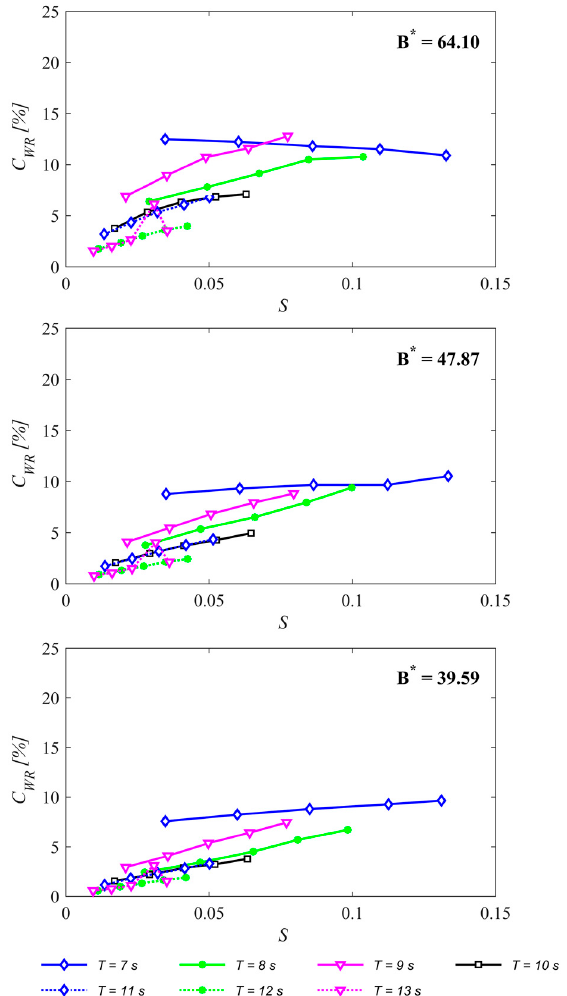
Figure 8. Variation of the capture width ratio ( C WR ) with the wave steepness ( S ) for regular waves (Series A); and for different values of the wave period ( T ) and damping coefficient ( B * ) (prototype data).